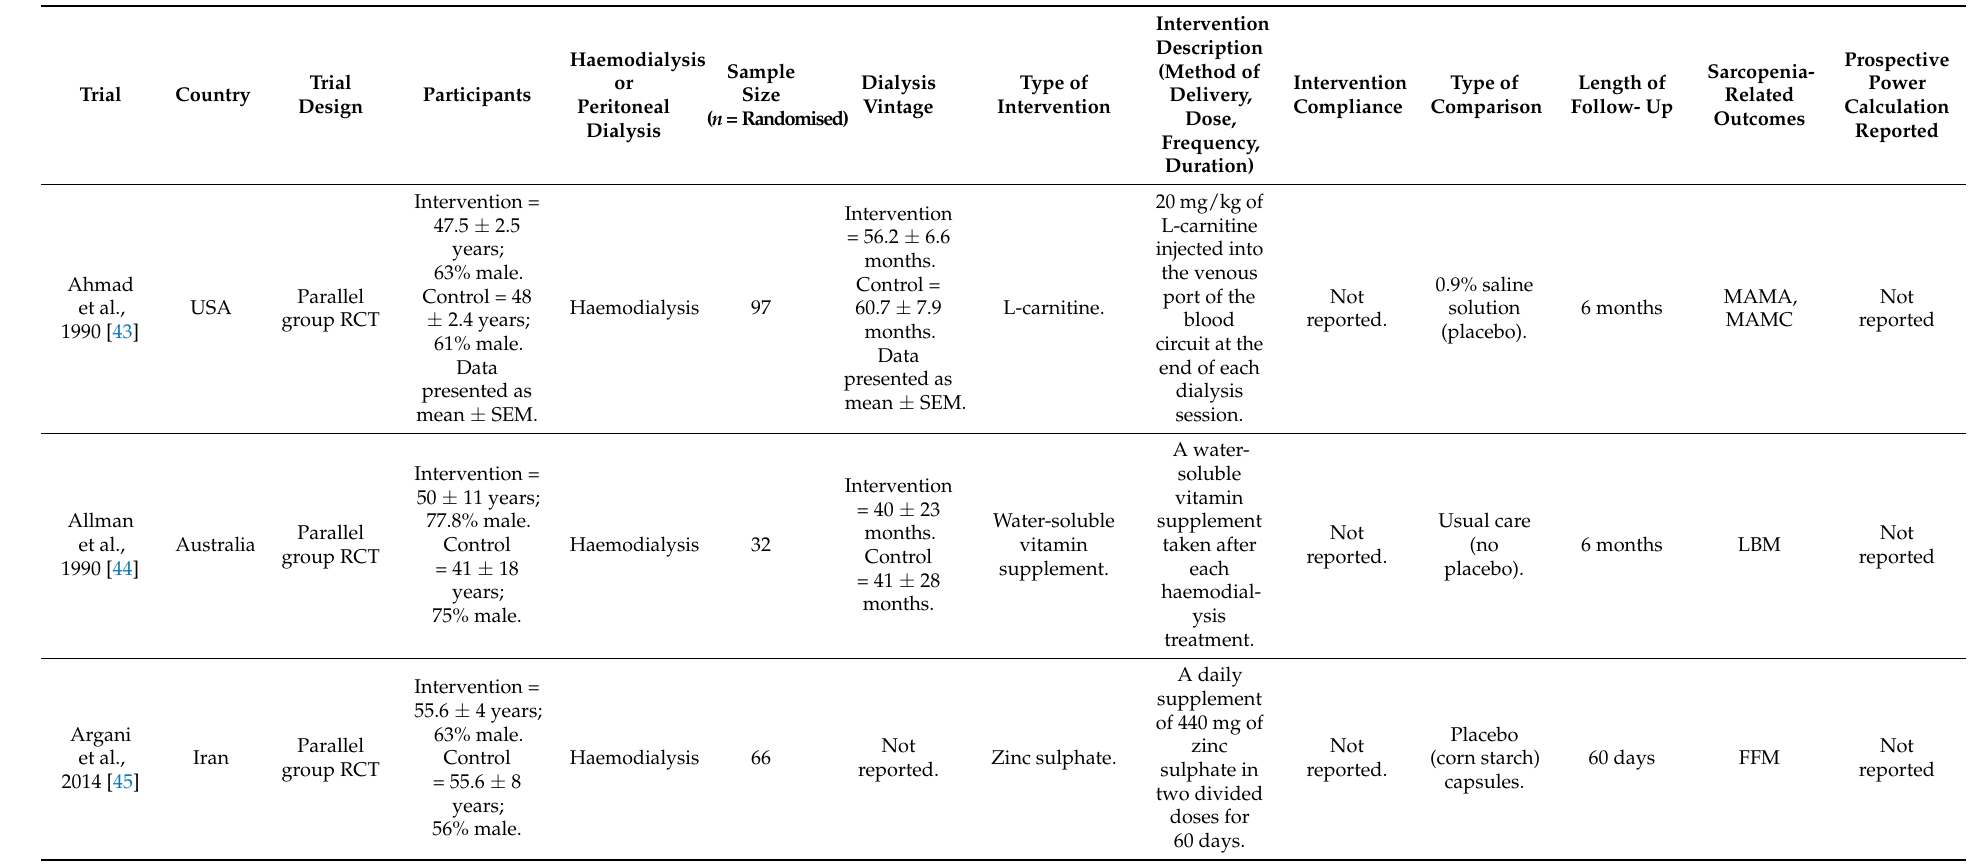
Table 2. Characteristics of trials containing either a nutritional or pharmacological intervention in the peritoneal dialysis and haemodialysis